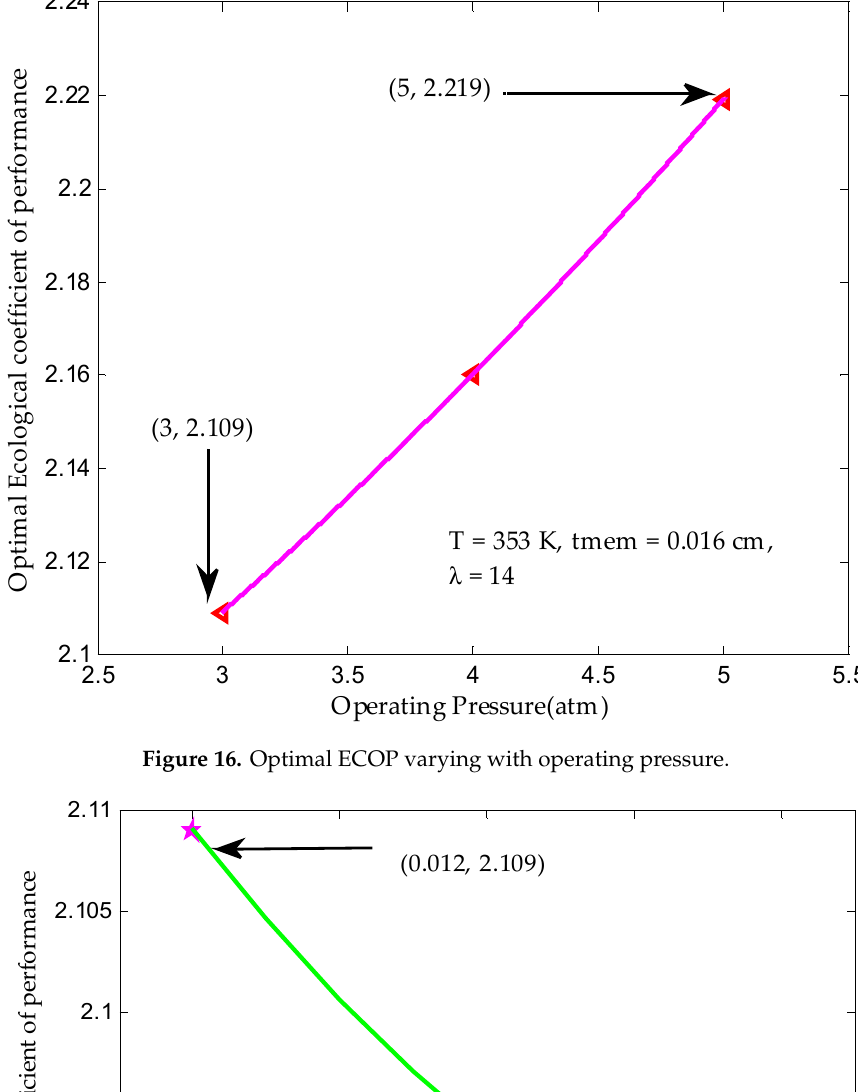
Figure 15. Optimal ECOP varying with operating temperature.